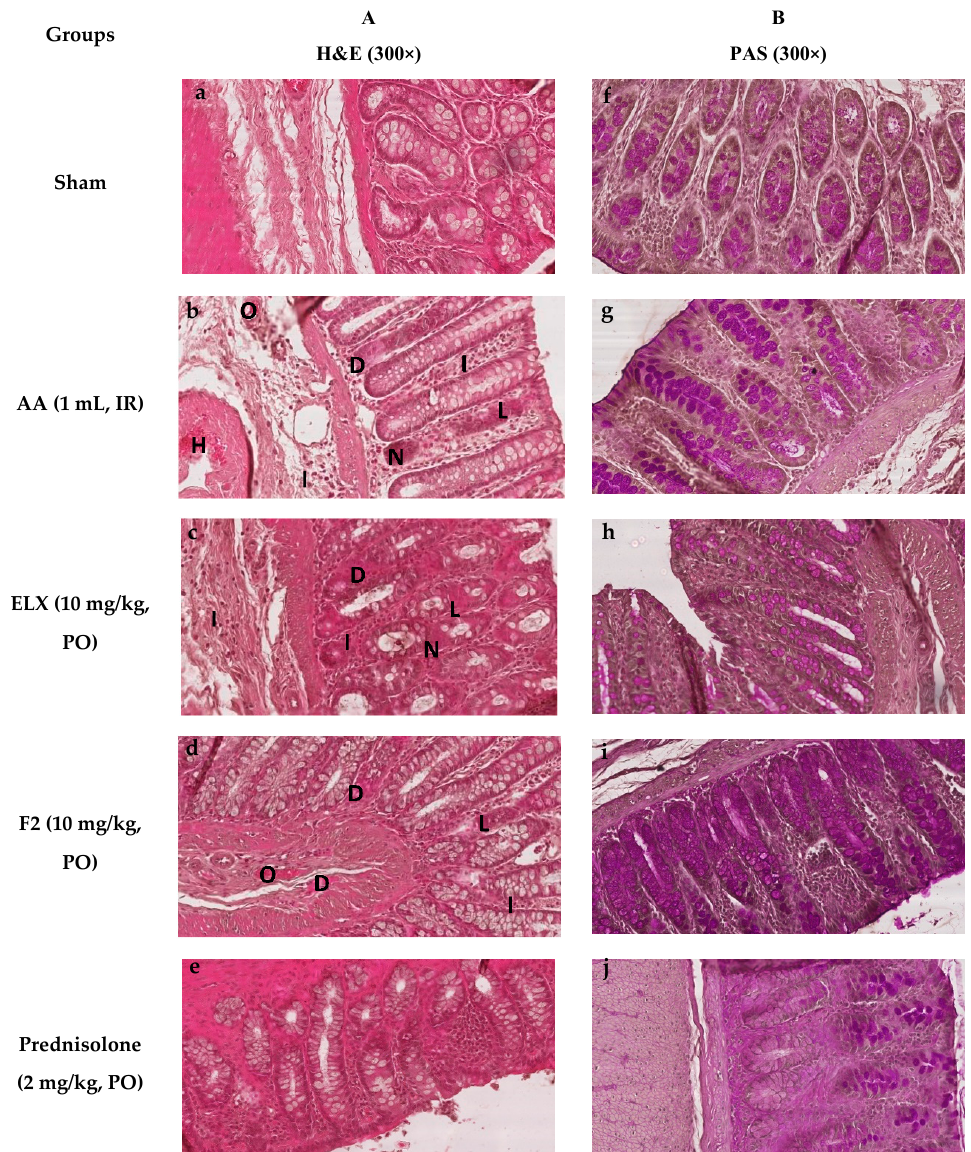
Figure 10. Impact of pure ELX and ELX loaded SLNs (F2) on histopathological changes in colon tissue in AA-induced colitis in Wistar albino rats (300 × ). Colon tissue were stained with ( A ) hematoxylin and eosin (H&E), and ( B ) PAS for microscopic evaluation. Sham control rats showing clear morphological structure. AA administered rats with H&E stain showed severe tissue damage of both mucosal and submucosal layers of intestine by showing areas of complete loss of goblet cells (L), remarkable necrosis (N), degeneration (D), as well as occlusion (O) of blood vessels and infiltration (I) of mucosa and submucosa by inflammatory cells. PAS staining showed severe loss of mucin and goblet cells. Pretreated rats with F2 showed better improvement compared to ELX whereas prednisolone showed complete protection against AA induced colon damage. ELX = Eluxadoline, F2 = formulation, AA = acetic acid, PO = orally, IR = intrarectally, H&E = hematoxylin and eosin, PAS = periodic acid Schiff’s.